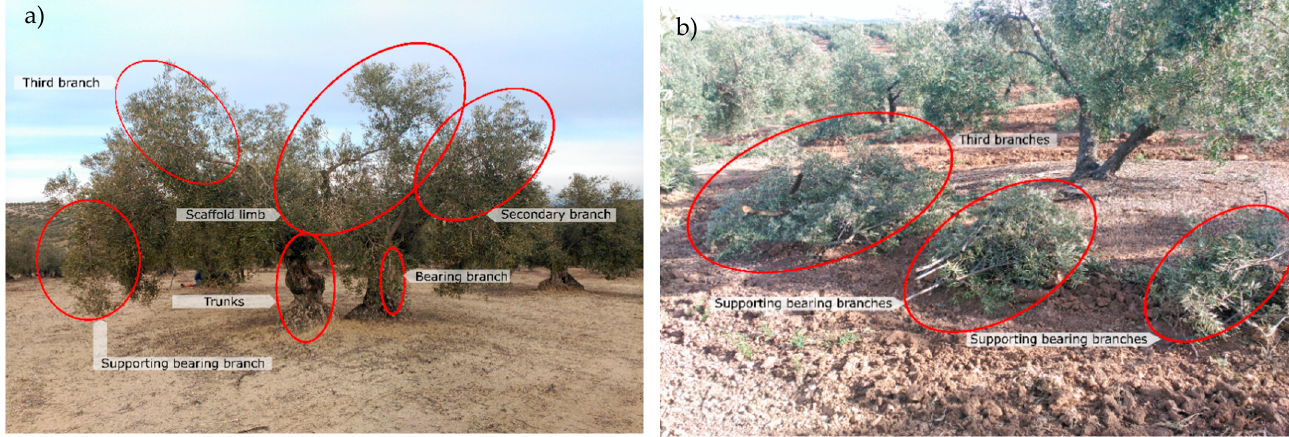
Figure 1. The five branch categories, shown on a traditional multi-trunk tree before pruning ( a ) and during branch classification before building the pruning windrows ( b ).